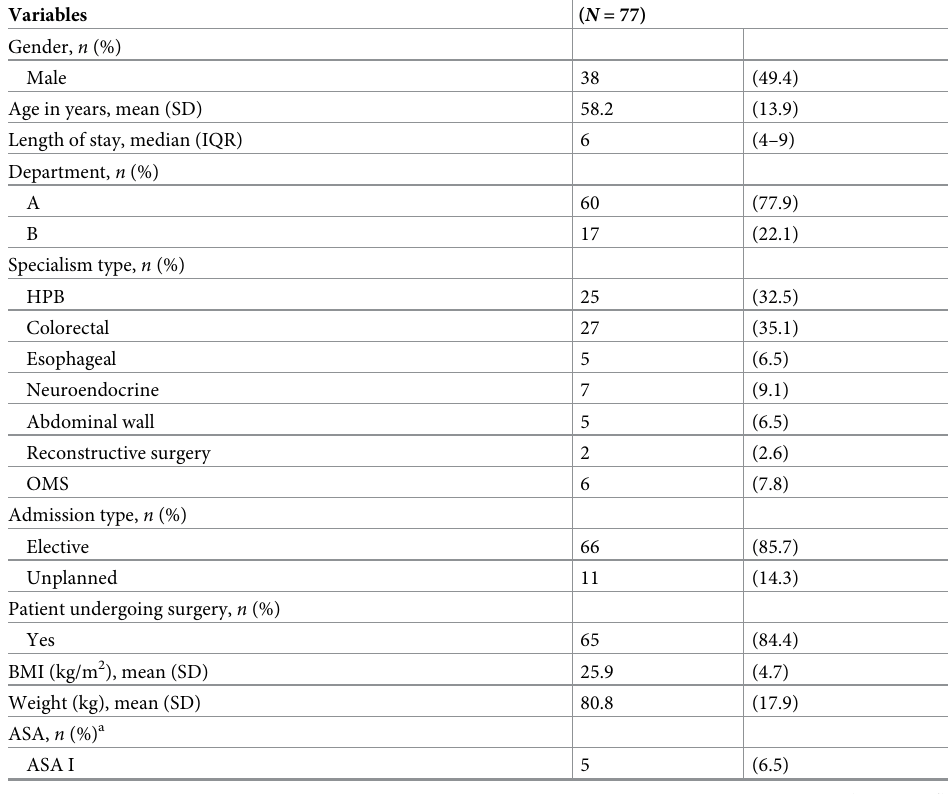
Table 1. Baseline characteristics of the